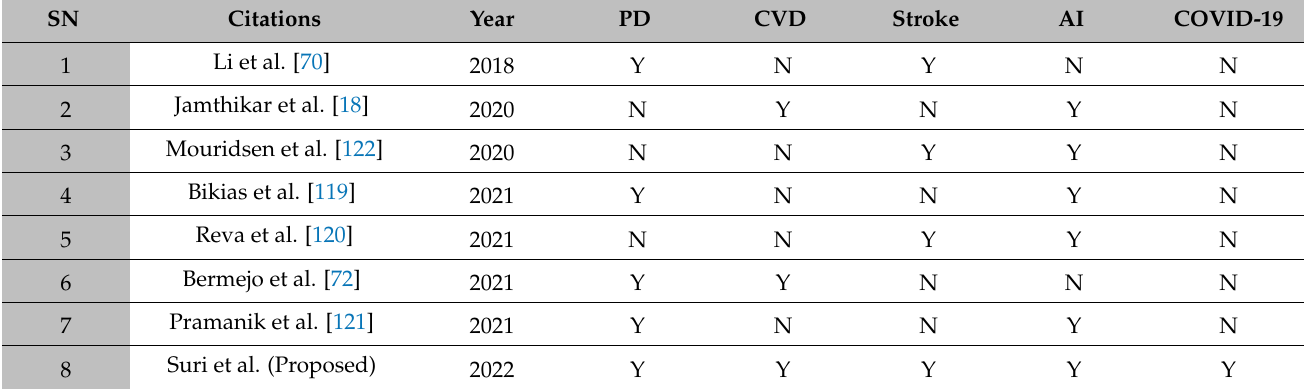
Table 6. Comparative analysis of studies CVD and stroke risk stratification in PD Patient. Y: